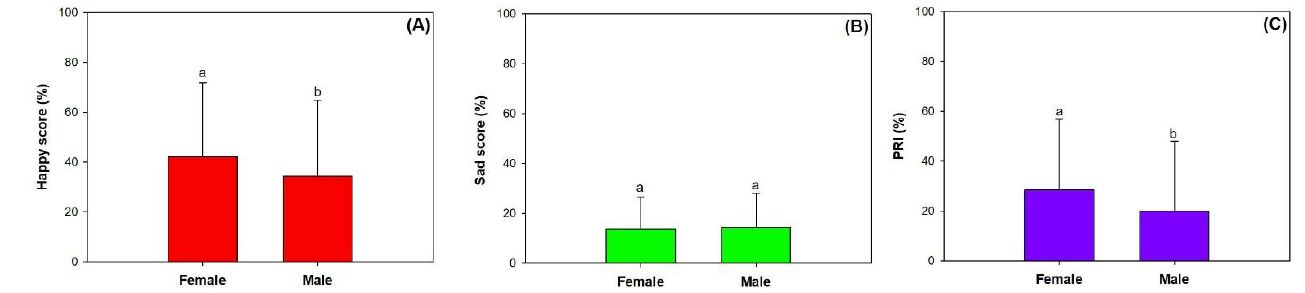
Figure 4. Differences of facial scores for happy ( A ), sad ( B ), and PRI (happiness minus sadness) ( C ) between female and male visitors in wetland forests of East China. Error bars stand for standard errors. Different letters indicate significant difference according to Duncan ’s test at the 0.05 level.